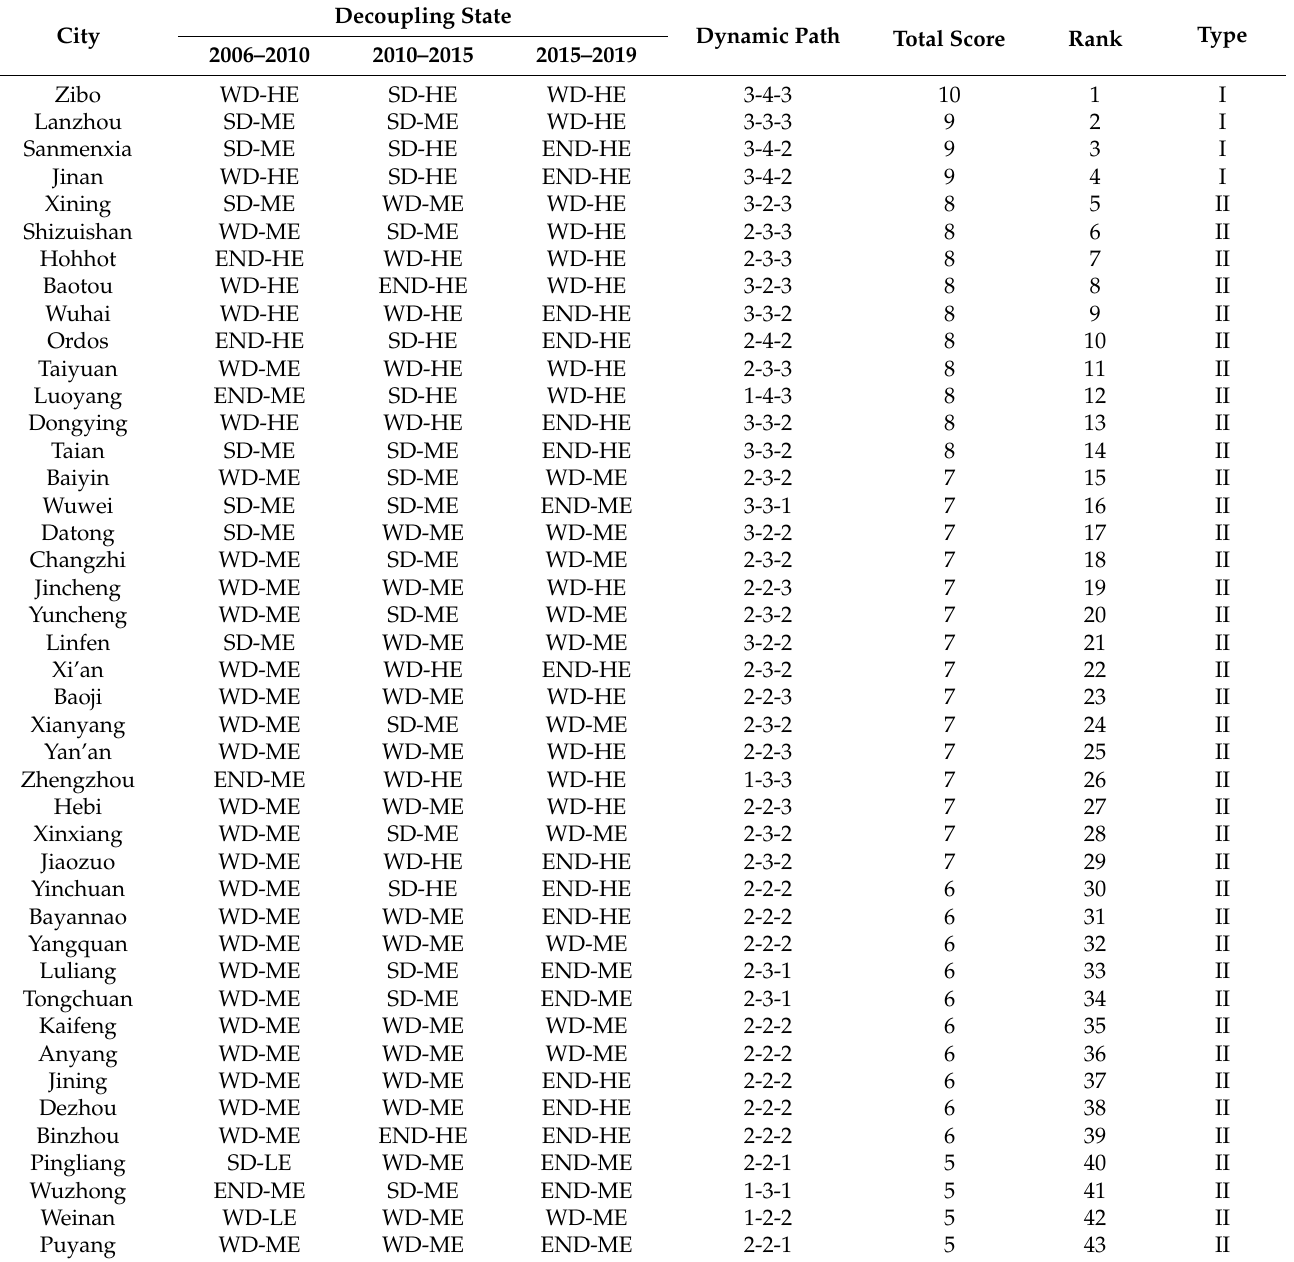
Table 8. Two-dimensional decoupling states and dynamic path of cities in the YRB,